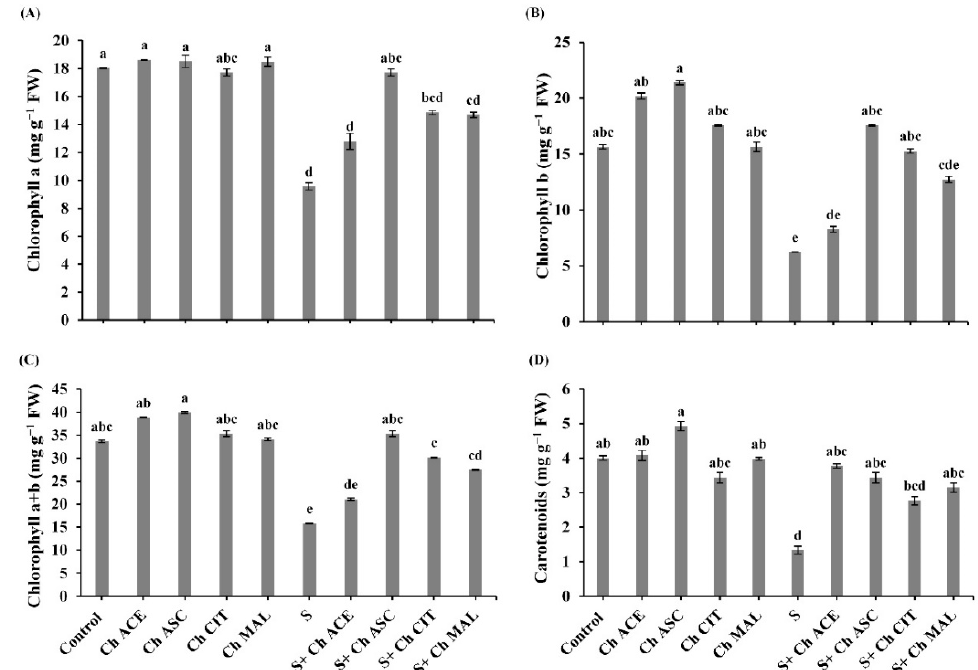
Figure 3. Effect of salinity (S) and foliar application of chitosan dissolved in different organic acids (Ch ACE, Ch ASC, Ch CIT and Ch MAL) and their interactions on ( A ) Chlorophyll a, ( B ) Chlorophyll b, ( C ) Chlorophyll a+b and ( D ) Carotenoids of tomato plants. Data are presented as means ± SE ( n = 3). Data followed by different letters are significantly different following Tukey’s honestly significant difference (HSD) test at p ≤ 0.05. FW: fresh weight.